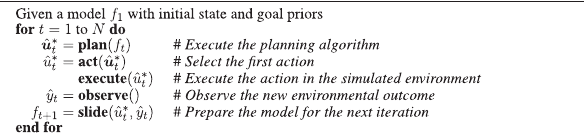
Algorithm 1. Experimental Protocol